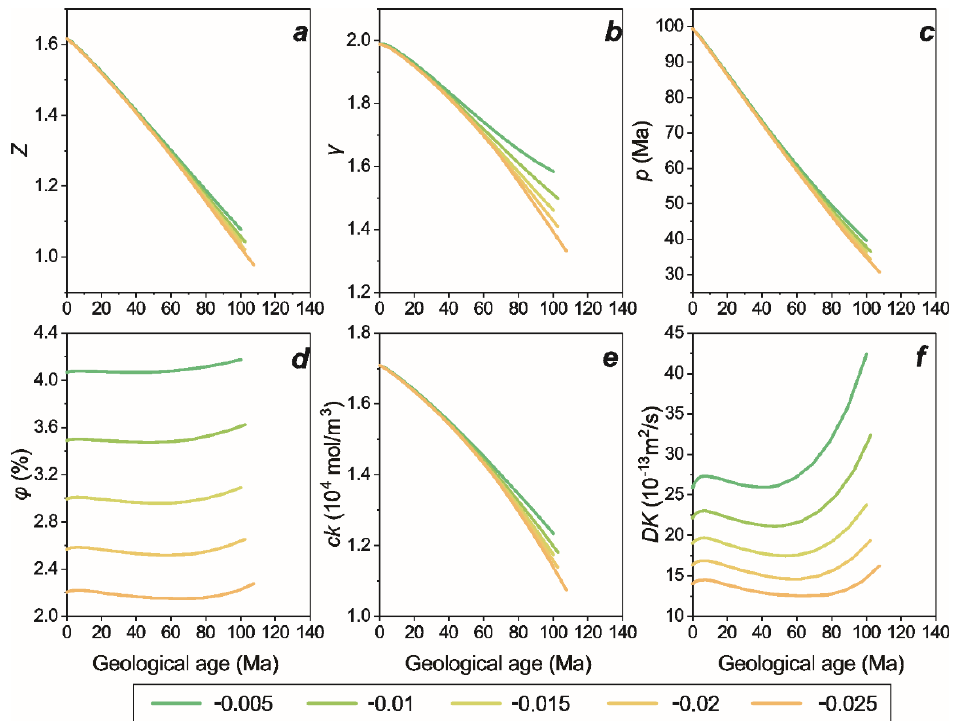
Figure 16. Evolution of compression coefficient ( a ), pressure coefficient ( b ), reservoir pressure ( c ), porosity ( d ), free gas concentration ( e ) and diffusion coefficient ( f ) for different pore compressibility values of the CN well after uplift.